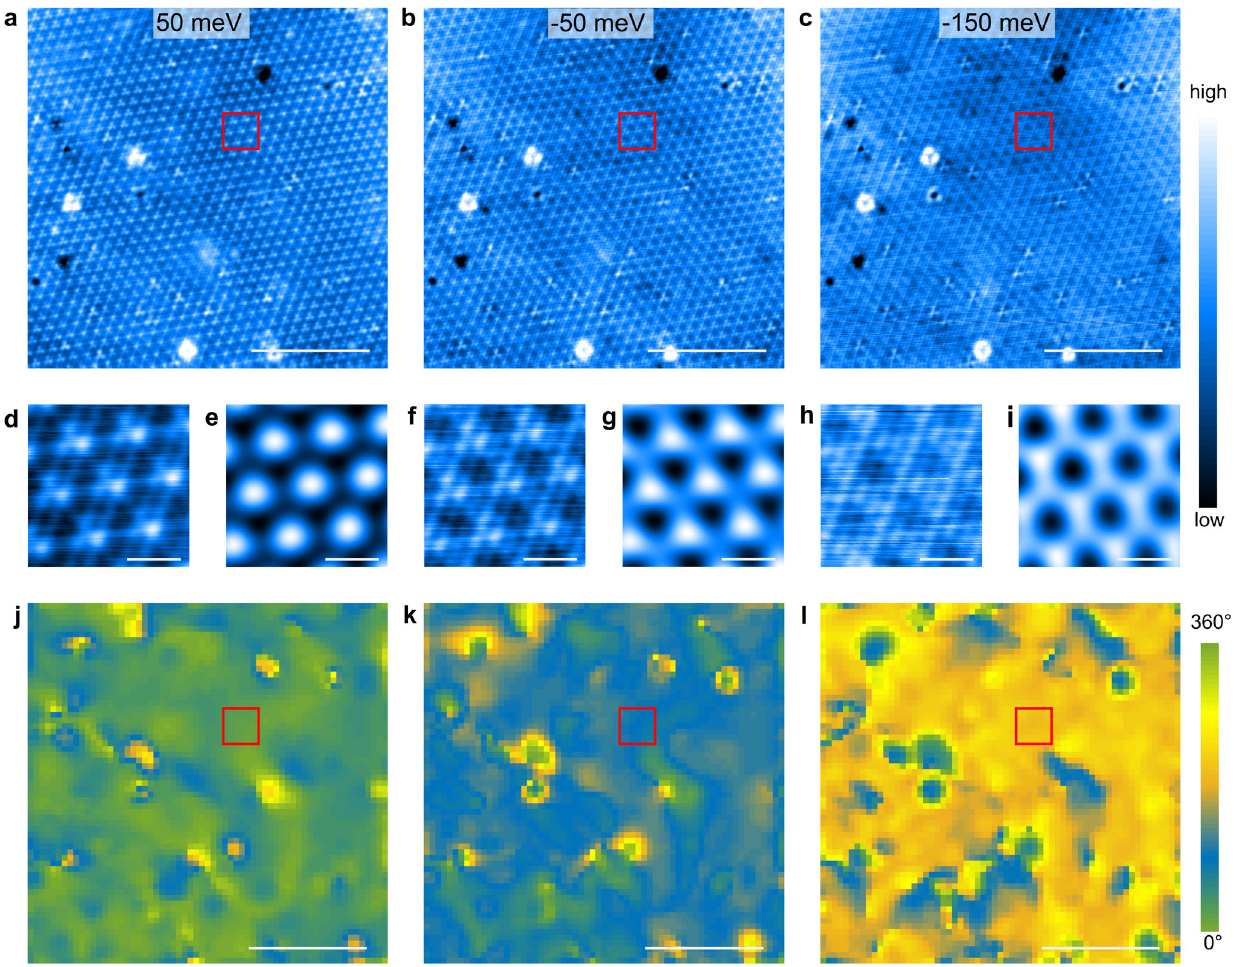
Fig. 2 Bias-dependent STM imaging of NbSe 2 at 1.2 K. Constant current topography showing the atomic lattice and CDW at a V b = 50 mV, b V b = − 50 mV and c V b = − 150 mV (Solely for visualization, the STM image in c has been corrected for diagonal running sharp lines (with wavelength much longer than those of the CDW) which arose due to a tiny horizontal tilt of the sample leading to a least signi fi cant bit issue in the digital – analogue conversion of the piezo voltage.) with I t = 100 pA. d , f and h are magni fi ed images of the areas marked by the red squares in a , b and c , respectively. The overall imaging contrast is very different in these cases, although the atomic lattice appears identical in all images (Supplementary Fig. 1). e , g and i shows the magni fi ed image of the large Fourier- fi ltered image of the CDWs at the same location as shown in d , f and h , respectively. It demonstrates that the variation of contrast observed in d , f and h is stemming from a variation in the appearance of the CDW at different biases. These appearances can be quanti fi ed by a single parameter: the dephasing parameter which describes the relative position of the three CDWs. j – l show the spatial variation of the dephasing parameter determined by fi tting the CDW modulations of the STM images shown in a - c , respectively. The red squares correspond to the same area that is highlighted in a – c and magni fi ed in d – i . Scalebars: 10 nm in a – c and j – l ; 1 nm in d –